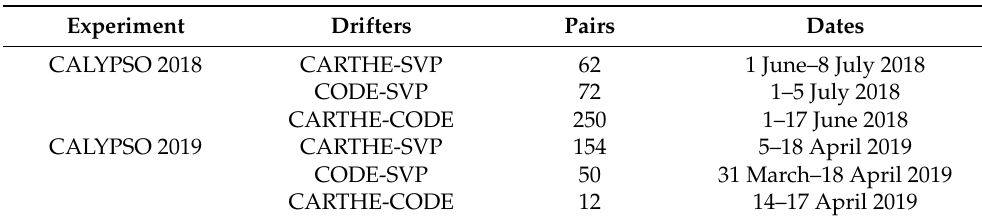
Table 1. Numbers of pairs of drifters with distance less or equal to 1 km using the CALYPSO 2018 and CALYPSO 2019 low-pass filtered datasets.